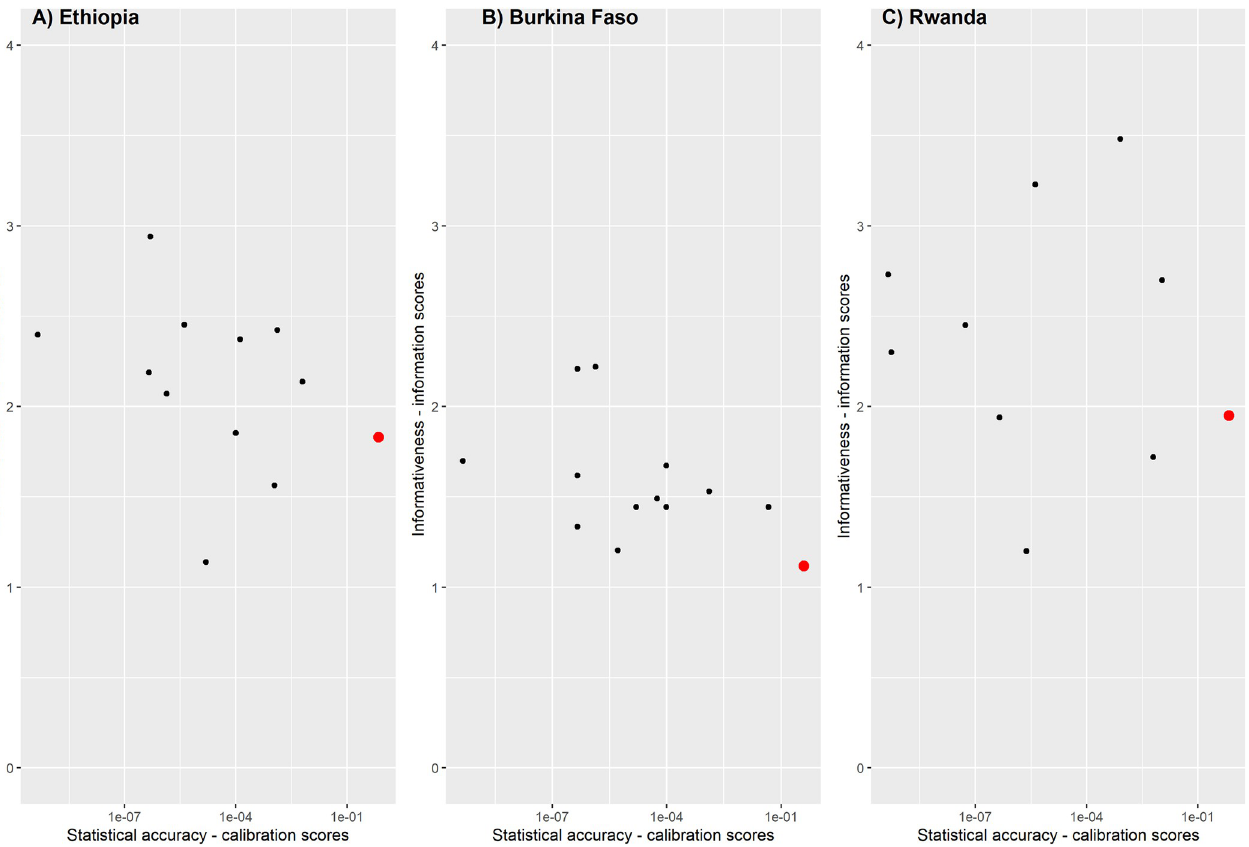
Fig 4. Calibration score (x-axis) by information score (y-axis) for A) Ethiopia, B) Burkina Faso and C) Rwanda. Black dots depict individual experts in the study while red triangles represent the item weights optimized Decision Maker.